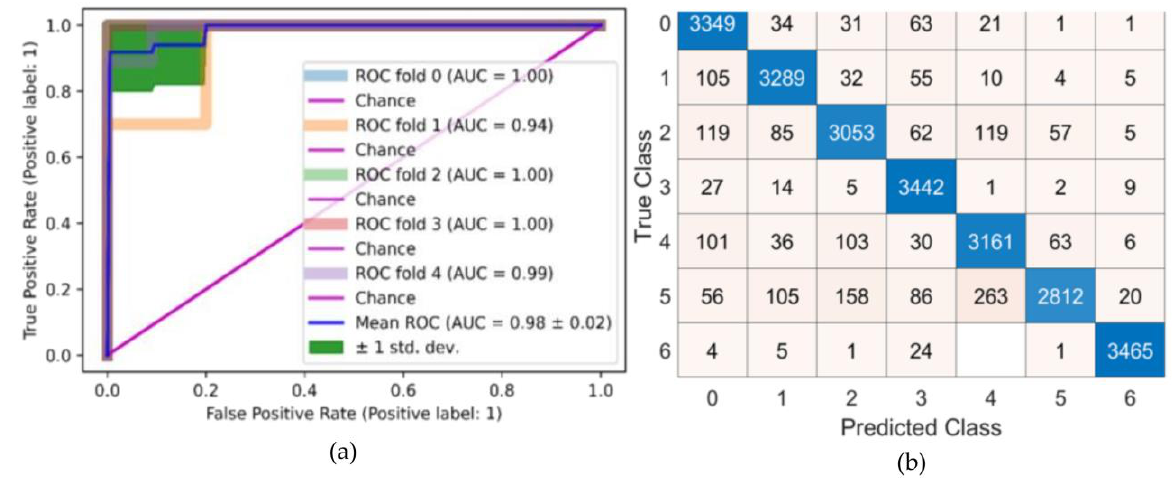
Figure 10. Classification results on HAM10000 ( a ) ROC curve of fine KNN ( b ) confusion matrix of fine KNN.